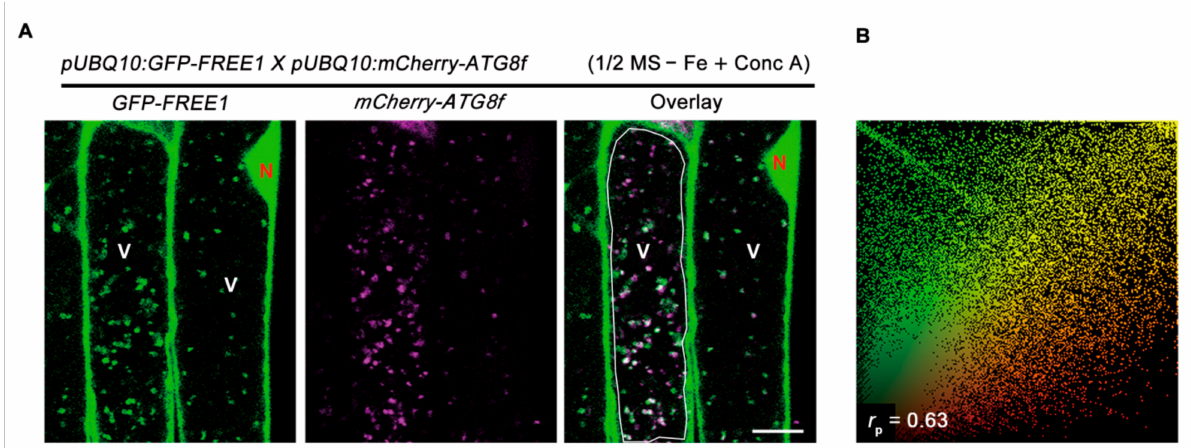
Figure 5. Colocalization of GFP-FREE1 with autophagic bodies inside vacuole. ( A ) Images of colocalization between GFP-FREE1 and mCherry-ATG8f in the lumen of vacuole. Six-d-old proUBQ10:GFP-FREE1 x proUBQ10:mCherry-ATG8f plants grown on 1/2 MS + Fe medium plates were transferred to 1/2 MS − Fe liquid medium with 0.5 µ M Conc A treatment as shown above before confocal imaging of the root elongation zone. Bars = 10 µ m. ( B ) Colocalization ratio of GFP-FREE1 and mCherry-ATG8f. Only vacuole regions indicated by white rectangle in ( A ) were used for quantification of colocalization ratio. Colocalization relationship indicated by r p value was measured from five independent confocal images by using Image J software with Pearson–Spearman correlation plugin. The maximum r p value is one standing for full